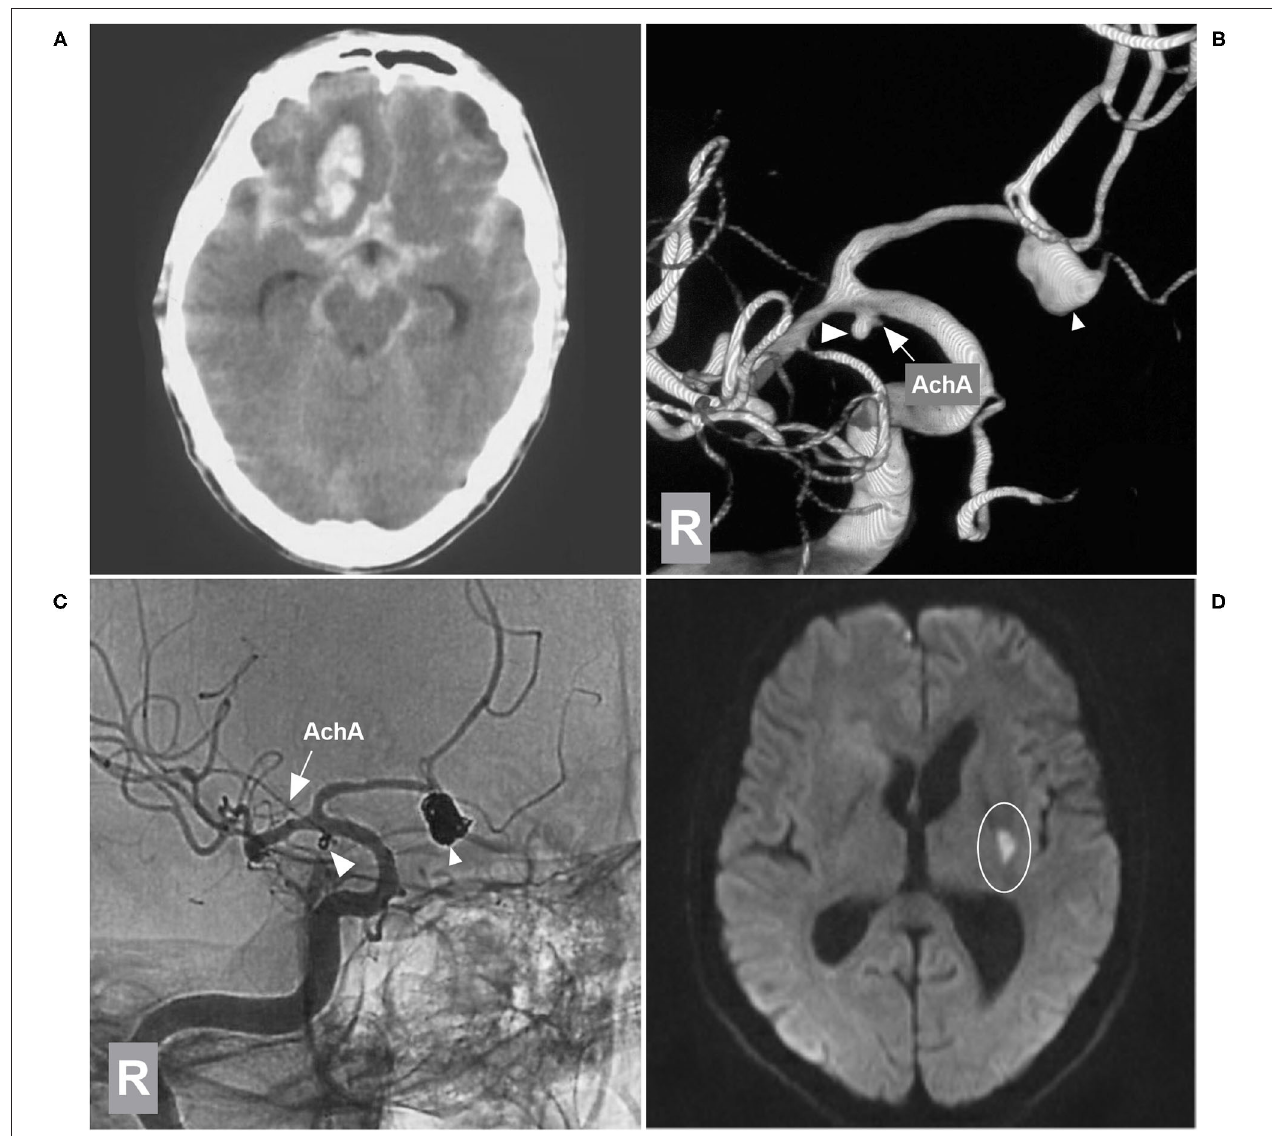
FIGURE 6 | EVT of the AchA aneurysm with brain infarction. (A) CT showing subarachnoid hemorrhage with a hematoma in the right frontal lobe base. (B) 3D-DSA of the right ICA showing type II AchA aneurysm (large triangle) and AcomA aneurysm (small triangle), and the arrow indicates the AchA. (C) Unsubtracted DSA of the right ICA showing that two aneurysms were coiled (large and small triangles); the AchA (arrow) was intact. (D) MRI DWI sequence showing the acute infarction (circle region) in the posterior limb of the internal capsule. AchA, anterior choroidal artery; AcomA, anterior communicating artery; CT, computed tomography; DSA, digital subtraction angiography; DWI, diffusion-weighted imaging; EVT, endovascular treatment; ICA, internal carotid artery; MRI, magnetic resonance imaging; R, right; 3D,